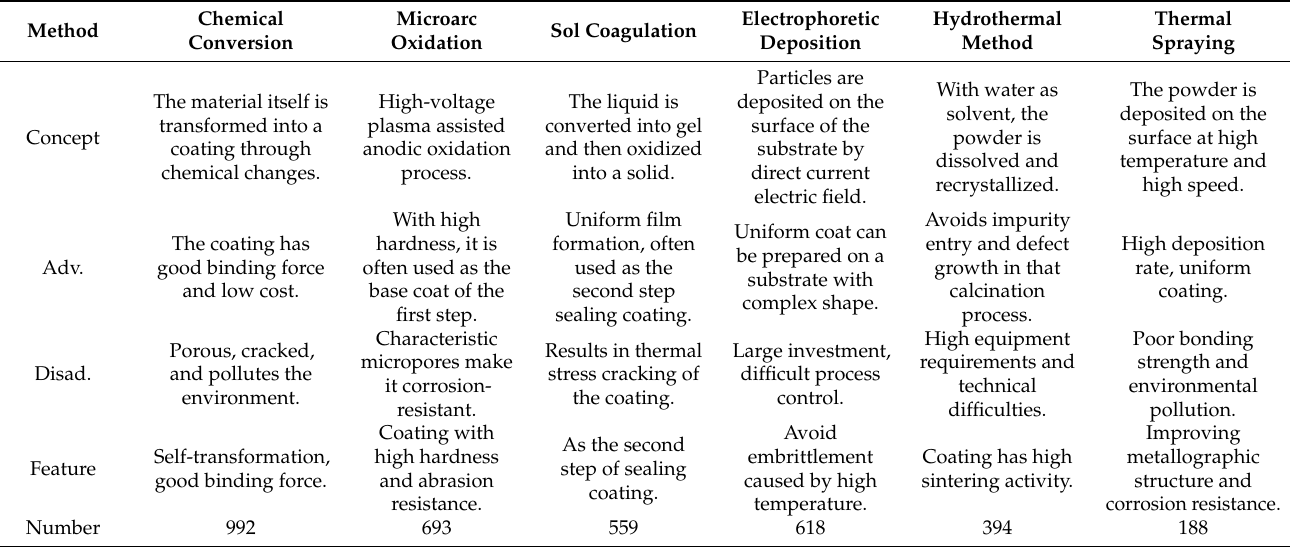
Table 1. Comparison of modification methods of medical magnesium alloy surface